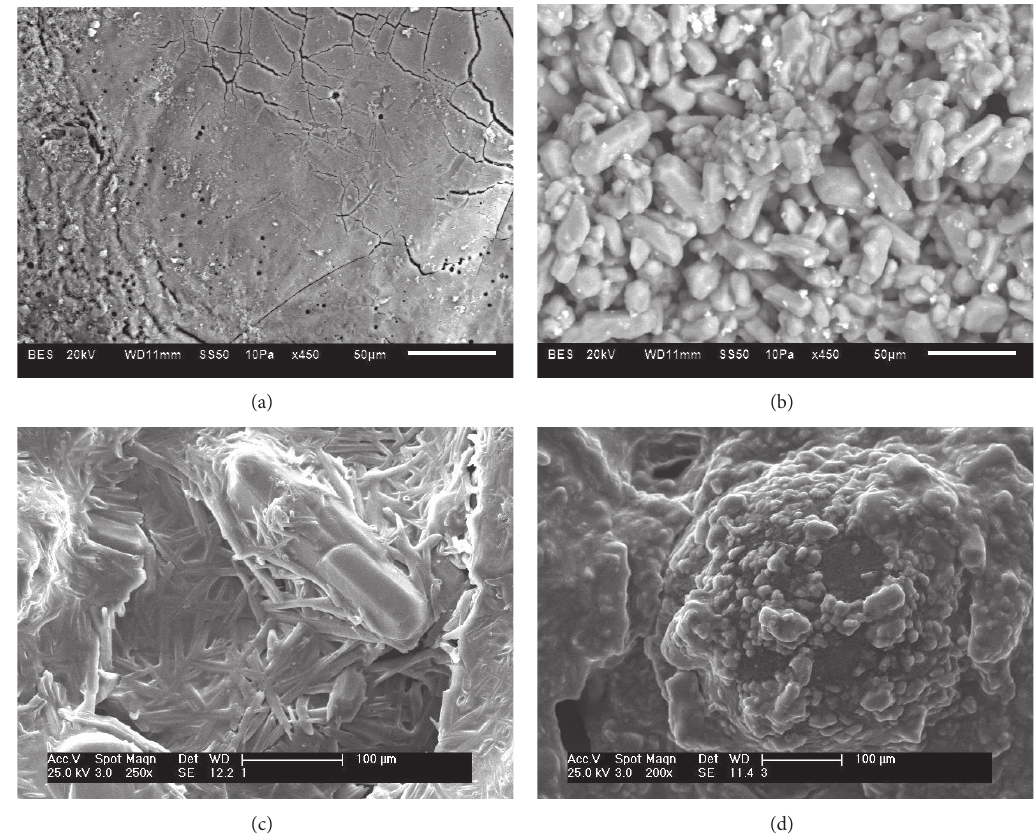
Figure 7: SEM images of (a) PZ, (b) PZ-HEMA-1: 3, (c) PZ-HEMA-1:6, and (d)